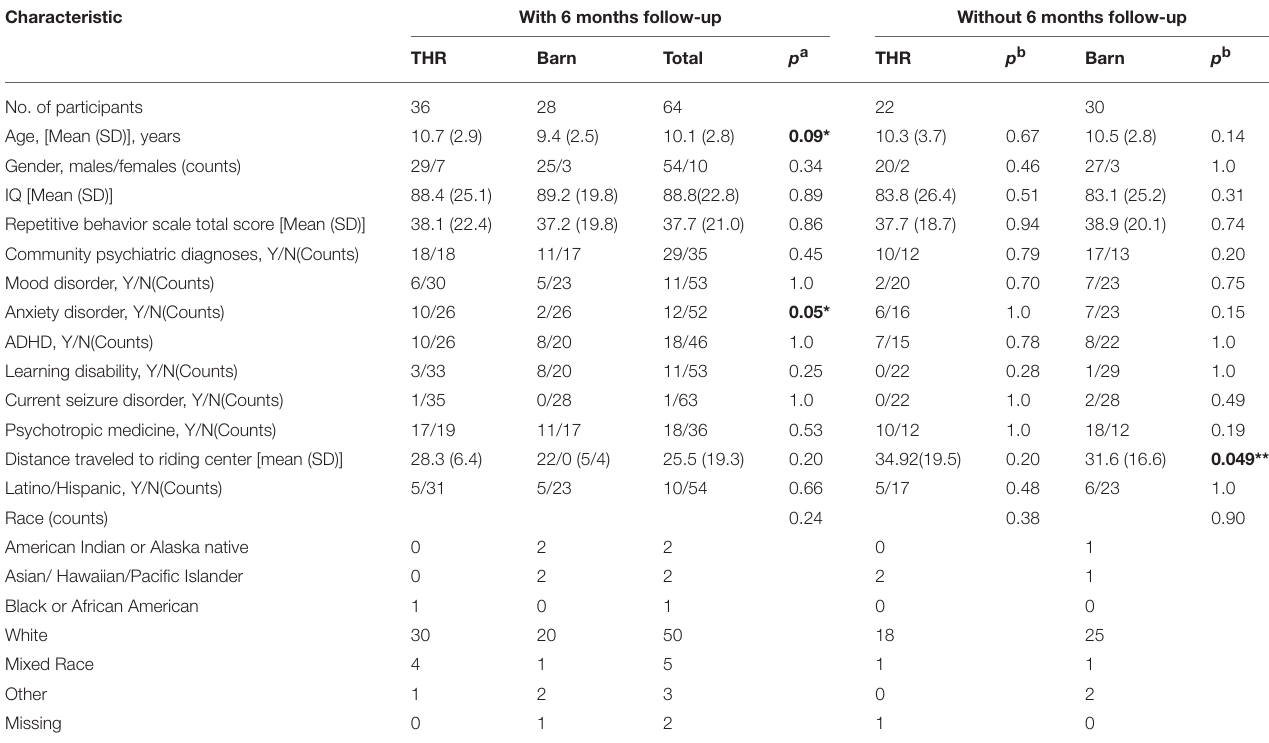
TABLE 1 | Demographics for participants with follow-up at 6 months’ post-treatment and those without follow-up. Characteristic With 6 months follow-up Without 6 months follow-up